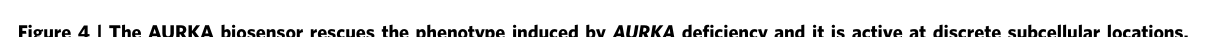
( a ) (Left panels) Immunofluorescent micrographs of non-transfected, GFP-AURKA and GFP-AURKA-mCherry stable U2OS cells silenced for endogenous AURKA and synchronized in metaphase. The mitotic spindle and centrosomal defects in cells following AURKA depletion and the corresponding rescue by GFP-AURKA and by GFP-AURKA-mCherry were detected by labelling the mitotic spindle with TUBA1A and the centrosomes with TUBG1. DNA was stained with DAPI. (Right panel) Quantification of the proportion of cells with centrosomal defects in the three cell lines transfected with a control- or an AURKA -specific siRNA. n ¼ 100 cells per condition scored in each of three independent experiments. ( b ) Representative fluorescence (GFP channel) and corresponding lifetime images of GFP-AURKA and GFP-AURKA-mCherry U2OS stable cell lines not synchronized (left panels) or synchronized in mitosis (right panels) and illustrating the presence of both proteins at the centrosome, in the cytosol and at mitotic spindles. Graphs: corresponding quantification of the lifetime of EGFP in the two cell lines and in the indicated subcellular compartments. Centrosomes were labelled with CETN1-iRFP670. n ¼ 30–40 cells per condition from three independent experiments. ( c ) Quantification of the lifetime of EGFP GFP-AURKA and GFP-AURKA-mCherry cells synchronized at mitosis and treated with dimethylsulfoxide (DMSO) or with MLN8237. n ¼ 30–40 cells per condition from three independent experiments. ( d ) (Left panels) Fluorescence (GFP channel) and lifetime images of GFP-AURKA and GFP-AURKA-mCherry cells transfected with an AURKA -specific siRNA and synchronized at mitosis. (Right panel) Quantification of EGFP lifetime in GFP-AURKA or in GFP-AURKA-mCherry cells transfected with a control- or an AURKA -specific siRNA and synchronized at mitosis; n ¼ 30–40 cells per condition from three independent experiments. Data represent means ± s.e.m. Pseudocolour scale: pixel-by-pixel lifetime. Scale bar, 10 m m. *** P o 0.001 against the corresponding ‘GFP-AURKA’ condition in a – d ; a P o 0.01 against the corresponding ‘GFP-AURKA-mCherry’ condition at the centrosome in b and the corresponding MLN8327 condition in c . NS, not significant. Statistical tests: two-way ANOVA in a , c and d ; Student’s t -test in b . NATURE COMMUNICATIONS|7:12674|DOI: